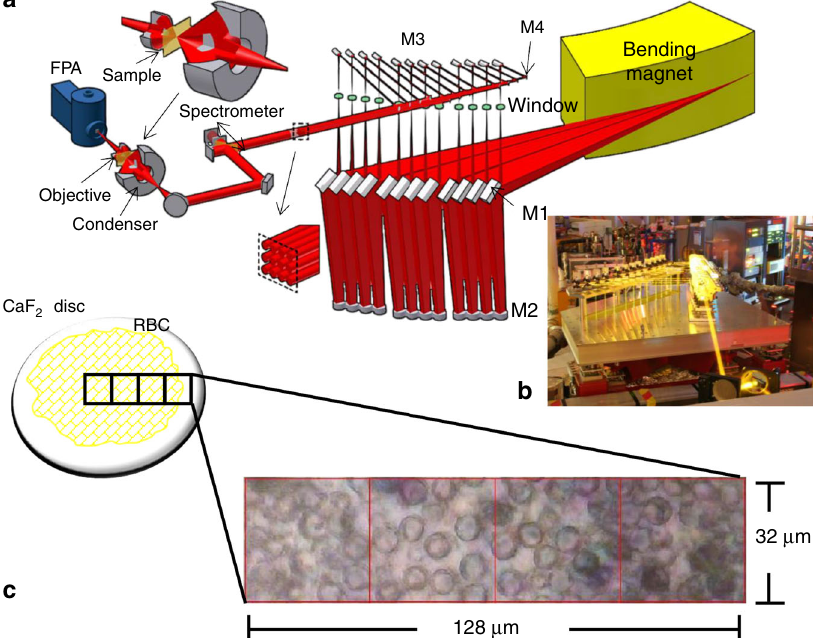
Fig. 6 Experimental schematic of mid-IR wide- fi eld imaging of polymer composites. a Schematic of the IRENI beamline (Synchrotron Radiation Centre, Wisconsin, USA), where M1 – M4 are mirror sets (adapted from Nasse et al. 27 , with permission). b Long-exposure photograph showing the combination of 12 individual beams to form a 3 × 4 matrix illuminating a focal plane array (FPA). c A bright- fi eld visible microscope image of a 60/40 wt% TPO initiated resin based composite (RBC) containing 8 µ m monodisperse spherical silica fi ller